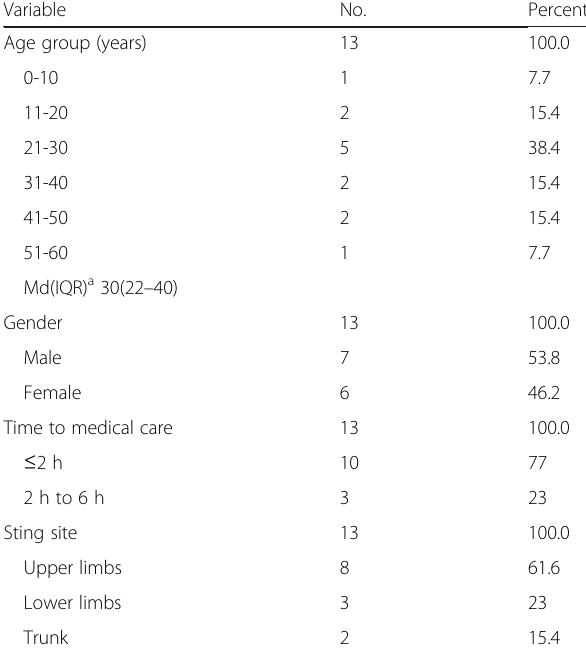
Table 2 Demographic profile of victims, elapsed time from envenomation to medical care and affected area of the body by T. silvestris stings in Pará state, eastern Amazon, Brazil Variable No.